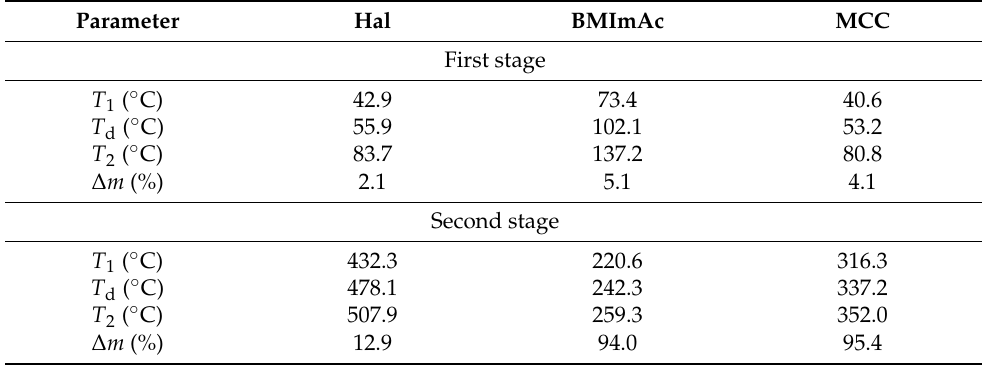
Figure 5. TG ( a ) and DTG ( b ) patterns for the individual components of the IL/Hal/MCC ionogels. Table 4. Characteristic temperatures and weight-loss values for the individual components of BMImAc/Hal/MCC